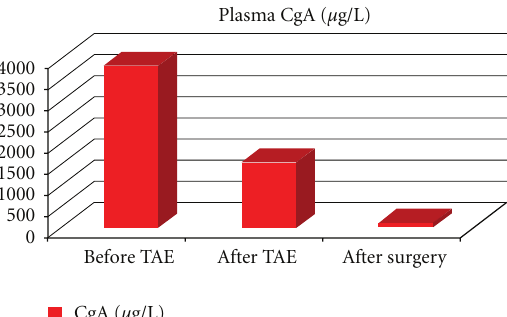
Figure 5: Changes in plasma CgA following TAE and surgery.